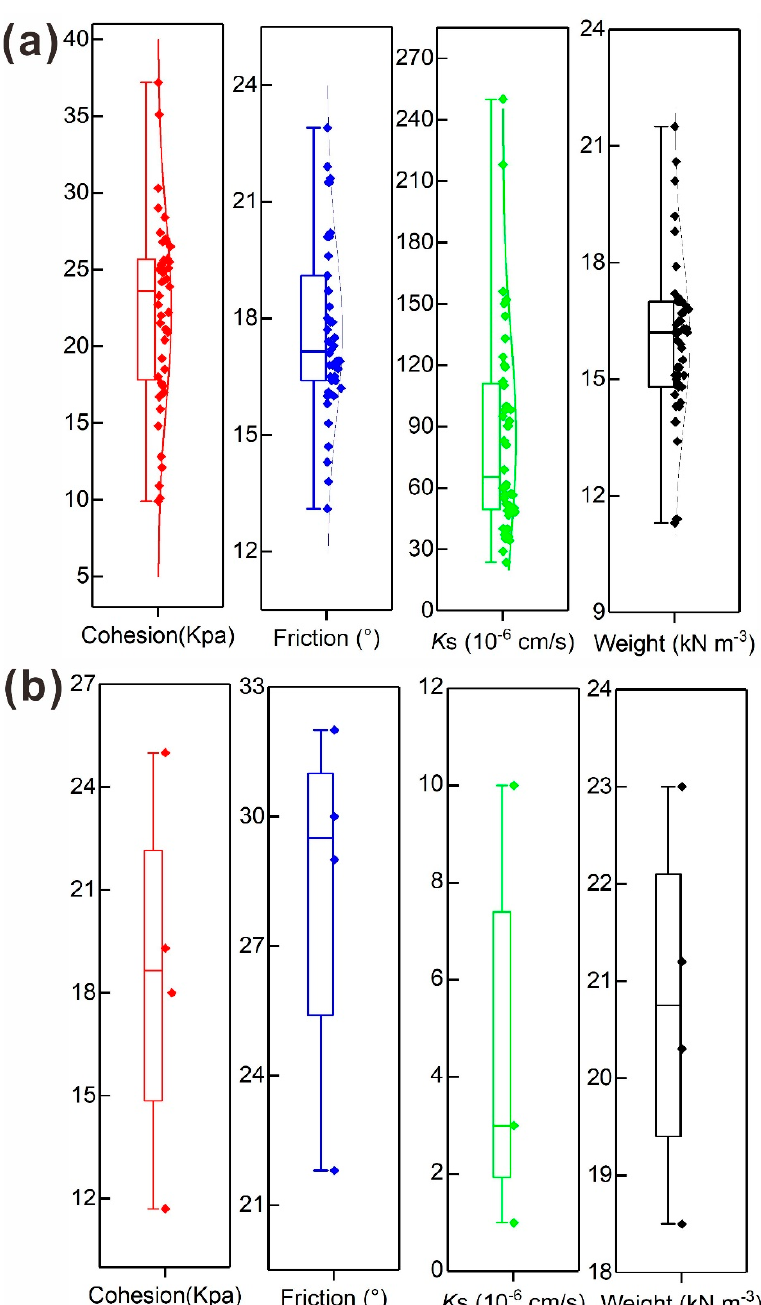
Figure 7. Distribution results of mechanical and hydrological parameters of ( a ) Quaternary soil samples and ( b ) Tertiary mudstone samples.